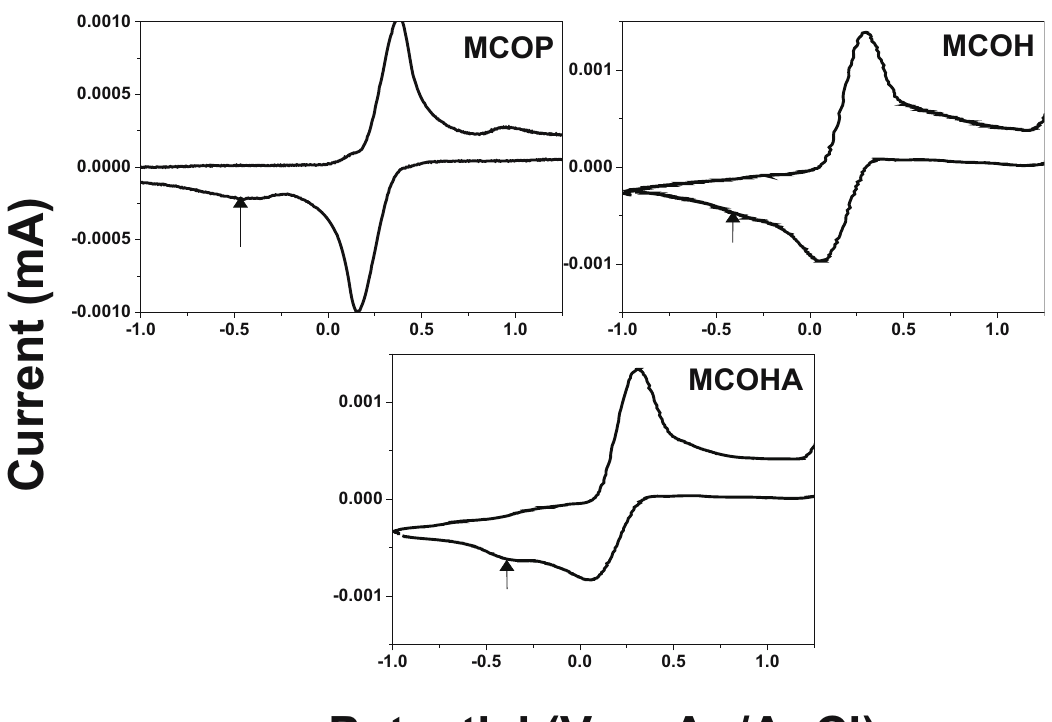
Figure 8: Voltammograms of the MCO synthetized by the methods: ( top left ) Pechini, ( top right ) hydrothermal with NaOH, and ( bottom ) hydrothermal with